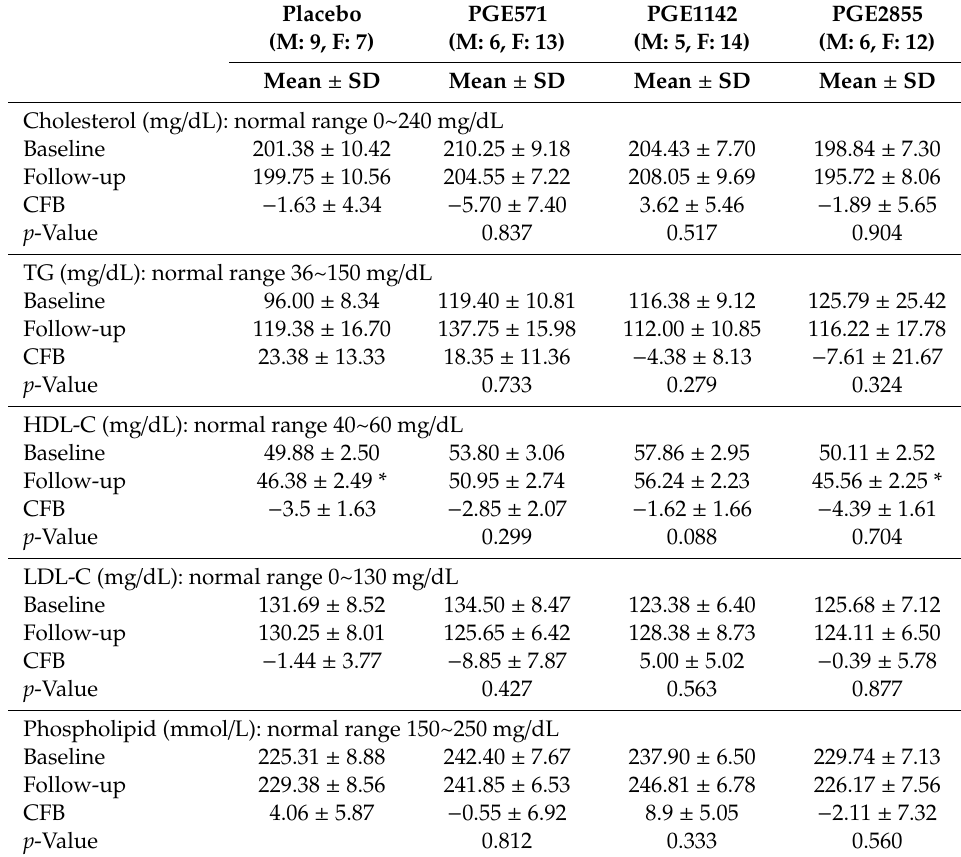
Table 7. E ff ect of supplementation of PGE for 12 weeks on changes of lipids metabolism in subjects with overweight or